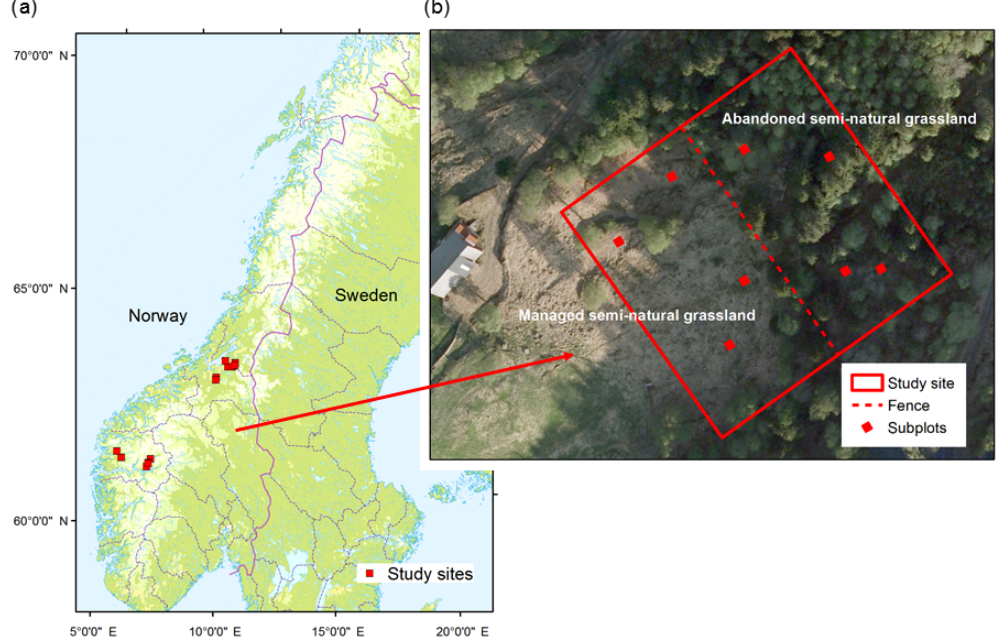
Figure 1. The study design. (a) The locations of the 14 study sites, which each comprised of (b) two plots, including four subplots each. One of the plots was located in extensively managed semi-natural grassland and the other plot was located in the adjacent abandoned semi-natural